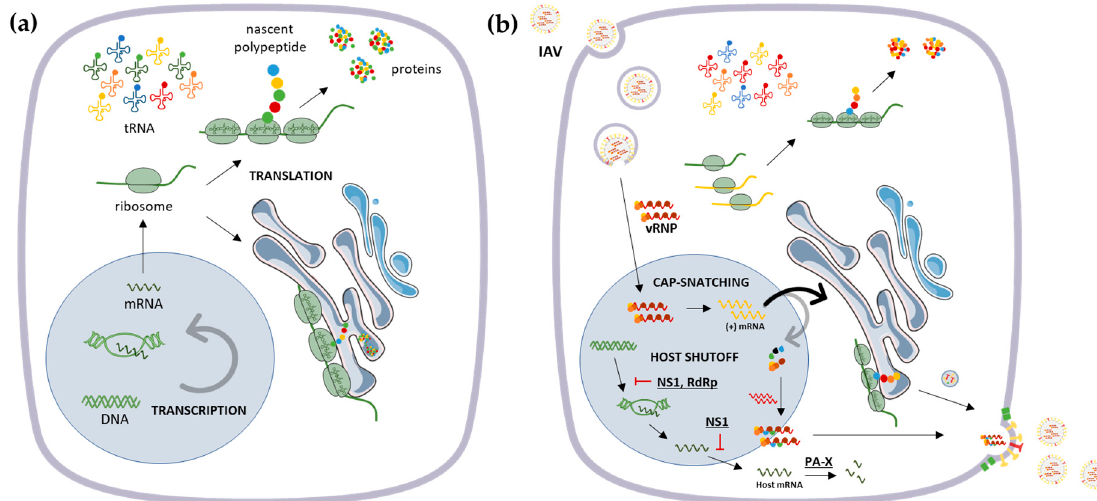
Figure 1. Schematic representation of the transcription and translation machinery in ( a ) uninfected and ( b ) influenza A virus (IAV)-infected cells. ( a ) After being transcribed and processed in the nucleus, mRNA is exported to the cytoplasm where ribosomes initiate their translation. Afterwards, it can either remain free at the cytosol or attach to endoplasmic reticulum (ER) membranes. ( b ) Upon infection, IAV hijacks different stages of mRNA biogenesis and ultimately reduces host protein translation. The virus can also manipulate tRNA pools within the cell to enable the efficient translation of viral proteins. Viral proteins are represented underlined.